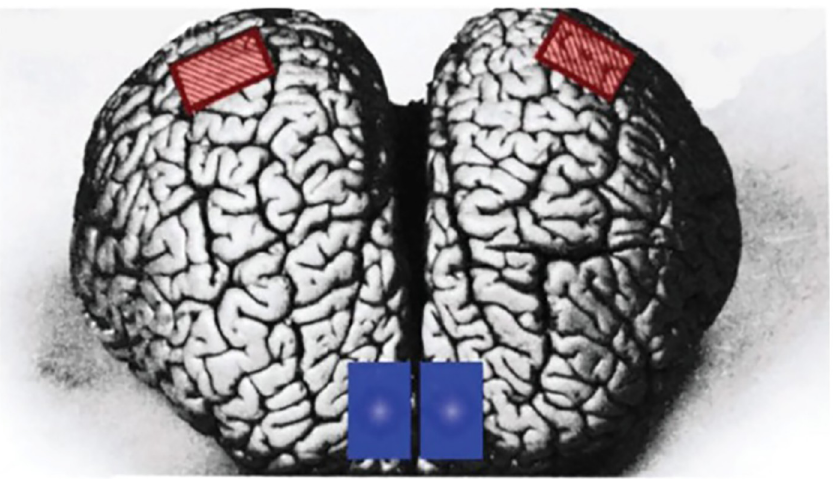
Fig 2. Boxes indicate where the brain samples were taken for the study. Anterior-superior view of the Tursiops truncatus ( Tt ) brain. The supralimbic (auditory; red) and anterior paralimbic (motor; blue) areas are marked on either side of the